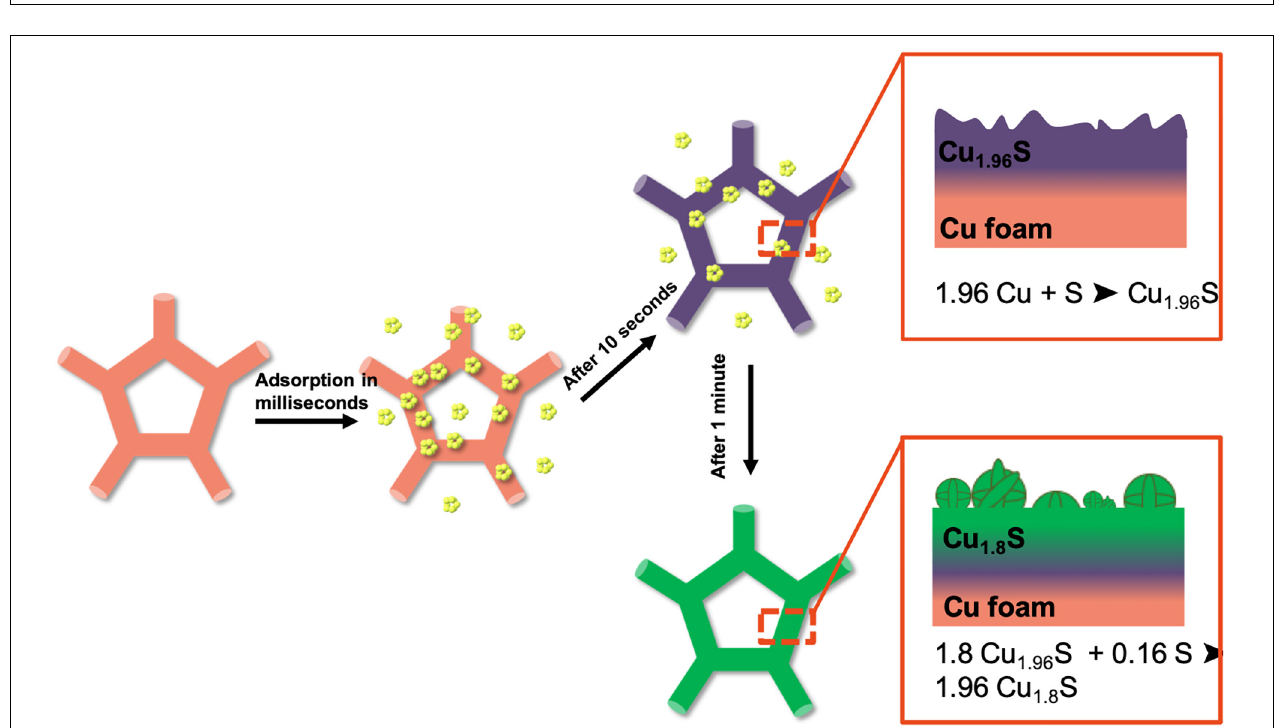
FIGURE 4 | Schematic representation of Cu 1 . 96 S and Cu 1 . 8 S formation on Cu foam.